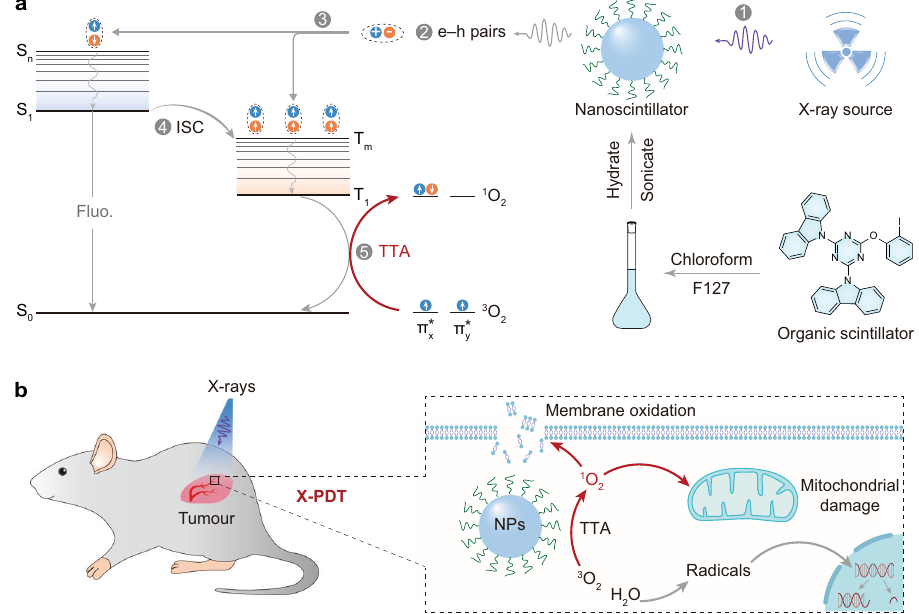
Fig. 1 | Schematic representation of X-PDT based on organic phosphorescent nanoscintillators. a Process to prepare organic nanoparticles in aqueous solution and subsequent 1 O 2 generation under X-ray irradiation. Speci fi cally, an organic scintillator 9,9 ’ -(6-iodophenoxy-1,3,5-triazine-2,4-diyl)bis(9H-car- bazole) (ITC) and PEG- b -PPG- b -PEG (F127) were dissolved in chloroform. The resultant solution was evaporated and dissolved in aqueous solution accom- panied by intense sonication to obtain organic nanoparticles. Under X-ray irradiation,electrons(orangecircles)aremainlyejectedfromtheinnershellof heavy atoms in ITC (step 1), generating massive electron-hole pairs (step